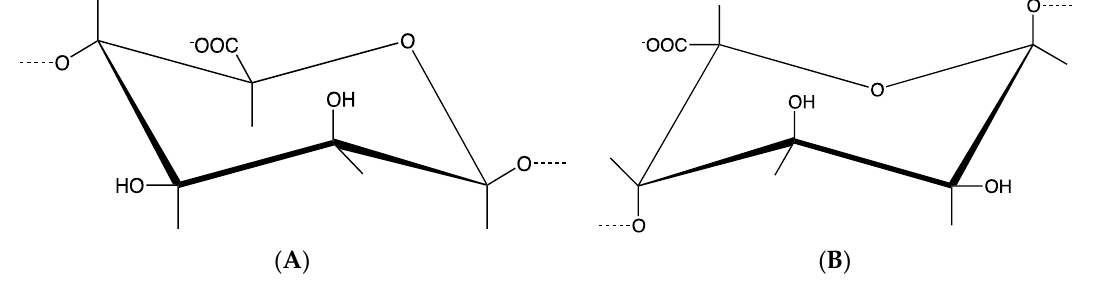
Figure 2. Structural units of the alginate block types: ( A ) β -(1–4)- D -Mannuronic acid; ( B ) α -(1–4)- L -Guluronic acid.